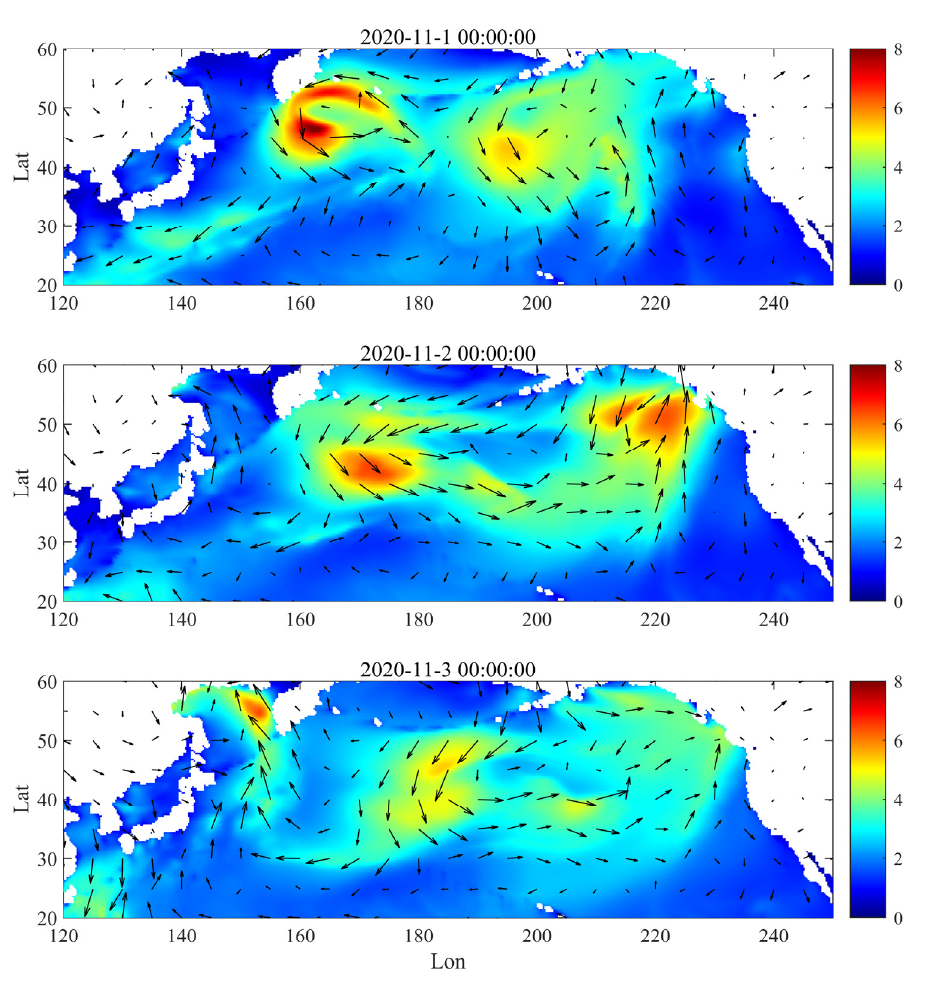
Figure 7. Significant wave height and wind field of north Pacific Ocean for three continuous days.